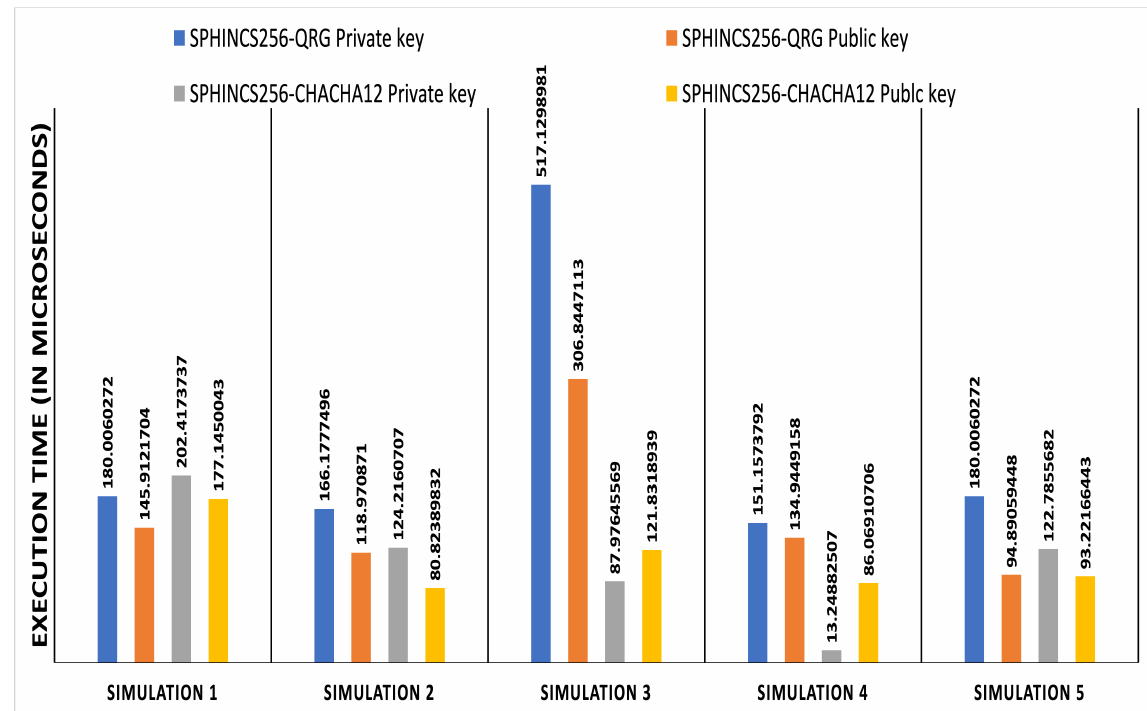
Figure 16. Execution Time for SPHINCS-Chacha12 vs.